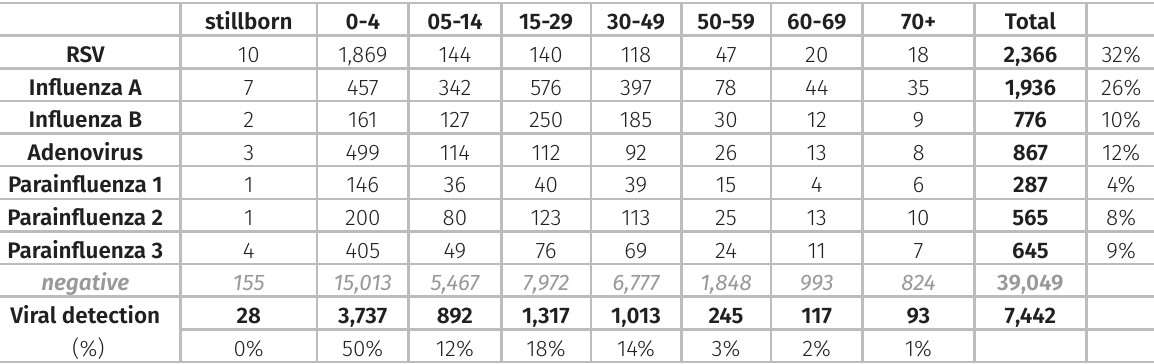
TABLE I. Virus detection by the SIVEP-Gripe (Information System of Epidemiological Surveillance - Influenza) per age group for the period Brazil,